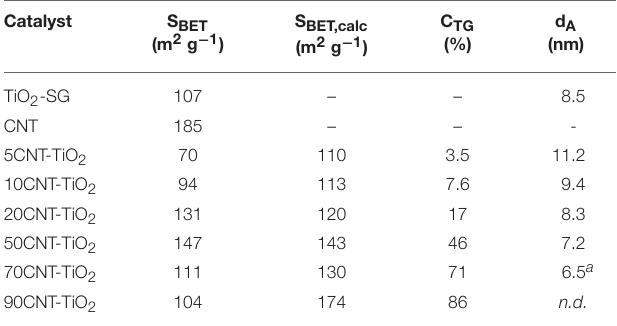
TABLE 1 | Surface area, carbon content, and dimensions of the anatase crystallites of TiO 2 and CNT-TiO 2 composites.